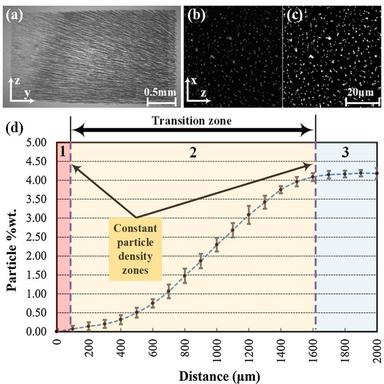
Results of nano-CT tests to measure particle weight ratio along the FGM: (a) 3D reconstructed data from Dragonfly was used to define a region of interest for further analysis. (b) An example of the raw 2D image used for analysing the particle content. (c) Binary version of the image shown in (c) as an outcome of thresholding. (d) Results of processing 105 images along the FGM sample show a particle gradient in the scanned area.